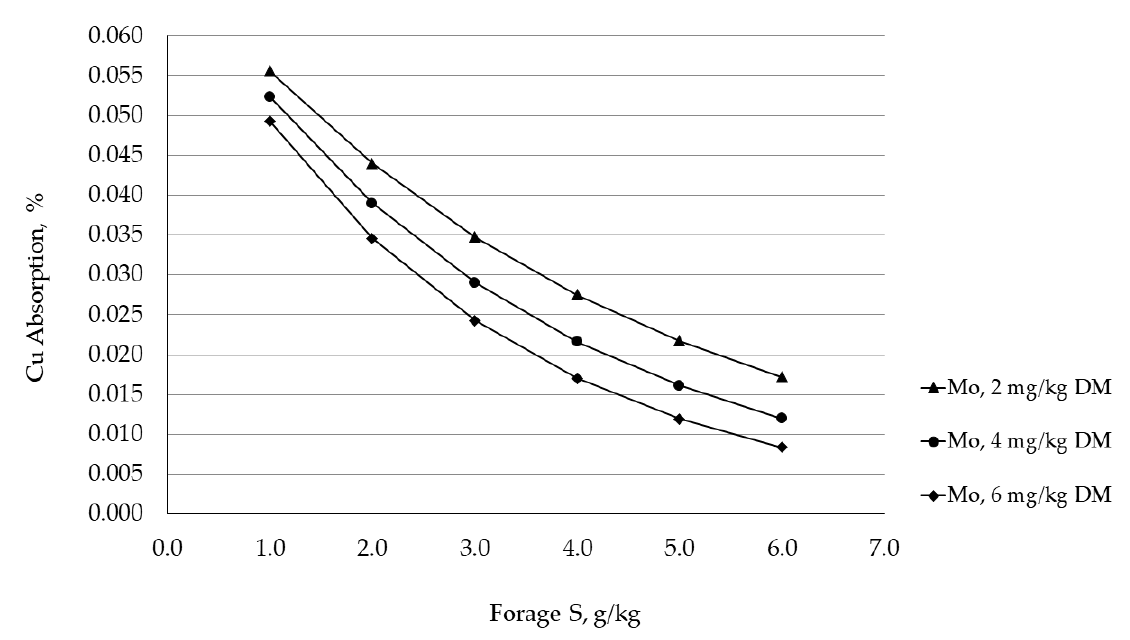
Figure 1. Hypothetical impact of the Mo × S interaction on Cu absorption in cattle. Ward and Spears [112] evaluated the long-term effects of low Cu diets with or without supplemental Mo (5 mg/kg of DM) on Cu status of growing steers. In their study, supplemental Mo decreased plasma Cu, ceruloplasmin concentration, and superoxide dismutase activity during the growing and finishing phases for steers not receiving supplemental Cu. However, Mo supplementation did not affect these parameters in Cu-supplemented steers, suggesting that Cu supplementation can reverse the negative effects observed with high-Mo diets. Molybdenum is an essential trace element required by all animals; however, cattle requirements for Mo are not defined. Nonetheless, the current maximum tolerable concentration of Mo for cattle is 5 ppm. Although reports of Mo deficiency are very rare [6], the antagonistic impact of Mo on Cu metabolism has been recognized for many years and is exacerbated by S. This interaction occurs through the creation of ruminal thiomolybdates formed when molybdate reacts with sulfide, produced by rumen microorganisms via the reduction of sulfate. Consequently, thiomolybdates associate with solid rumen digesta (bacteria, protozoa and undigested feed particles) forming insoluble complexes with Cu, therefore reducing Cu absorption and potentially leading to deficiency